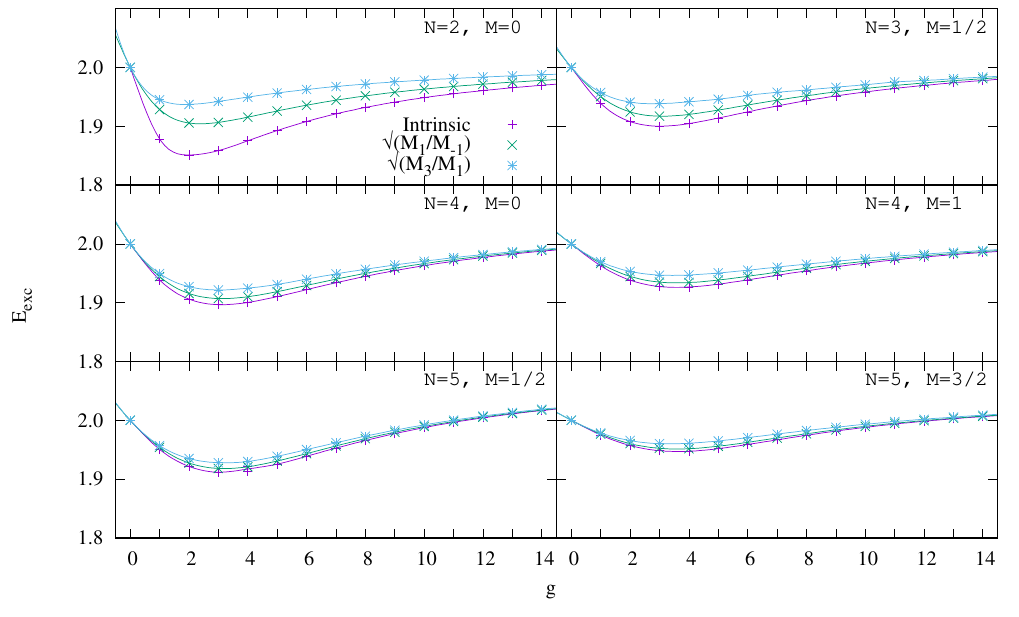
√ (cid:112) M 1 / M − 1 and M 3 / M 1 as a function of the interaction strength Figure 13. Ratios of the sum rules for several number of particles and spin configurations. The purple + signs correspond to the excitation energy of the main peak of the dynamic structure